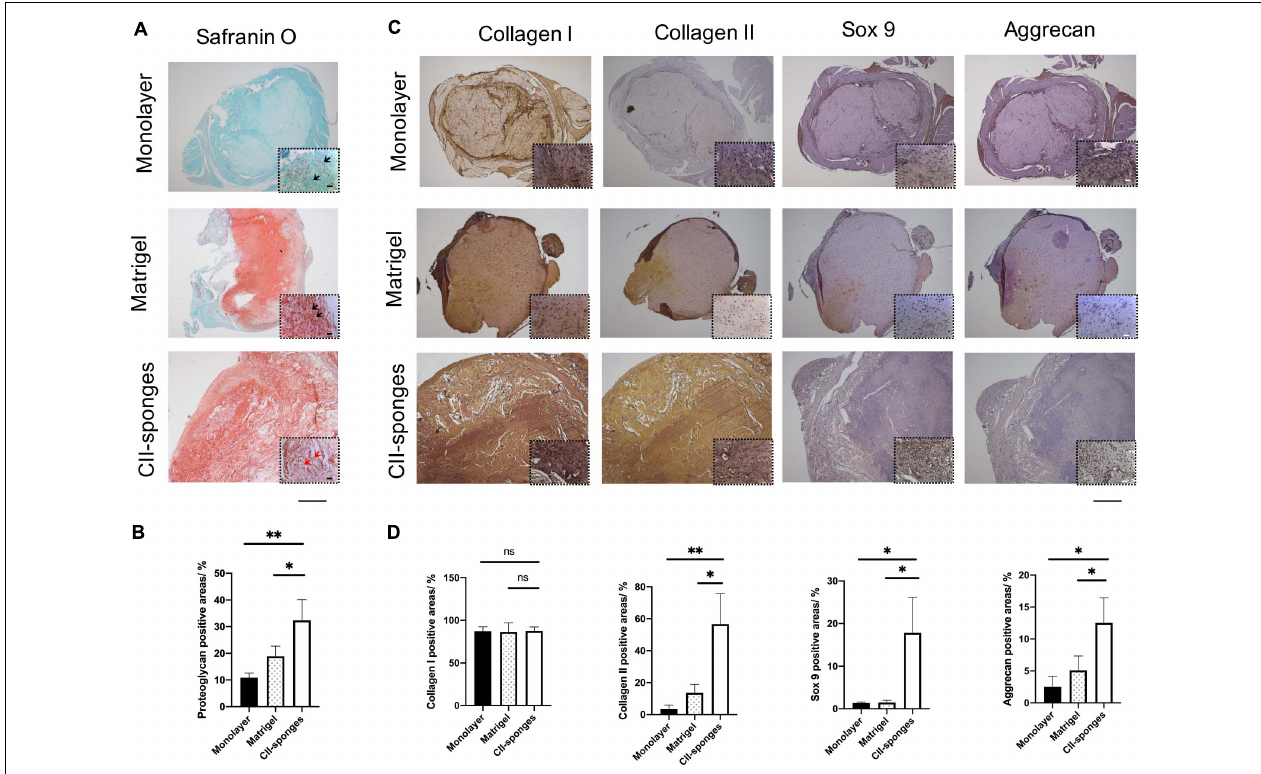
FIGURE 4 | Histological evaluation of the chondrogenic differentiation of TSPCs seeded in Monolayer, Matrigel, or CII-sponges. (A) Safranin O/Fast Green staining were applied to observe cells and proteoglycan expression in formed tissues. Scale bar 200 µ m and scale bar 20 µ m (The magnified photos in dot lines). (B) The proteoglycan positive areas were measured by Image ProPlus. ns, represented as no significance; * represented as P < 0.05, ** represented as P < 0.01, and *** represented as P < 0.001. (C) Immunohistochemistry staining was also used to confirm the expression of chondrogenic differentiation related proteins, including type I and type II collagen, Sox 9, and aggrecan, in continuous slices. Scale bar 200 µ m and scale bar 20 µ m (The magnified photos in dot lines). (D) The positive areas of these above proteins were quantified by Image ProPlus. ns, represented as no significance; * represented as p (cid:53) 0.05 and ** represented as p (cid:53)